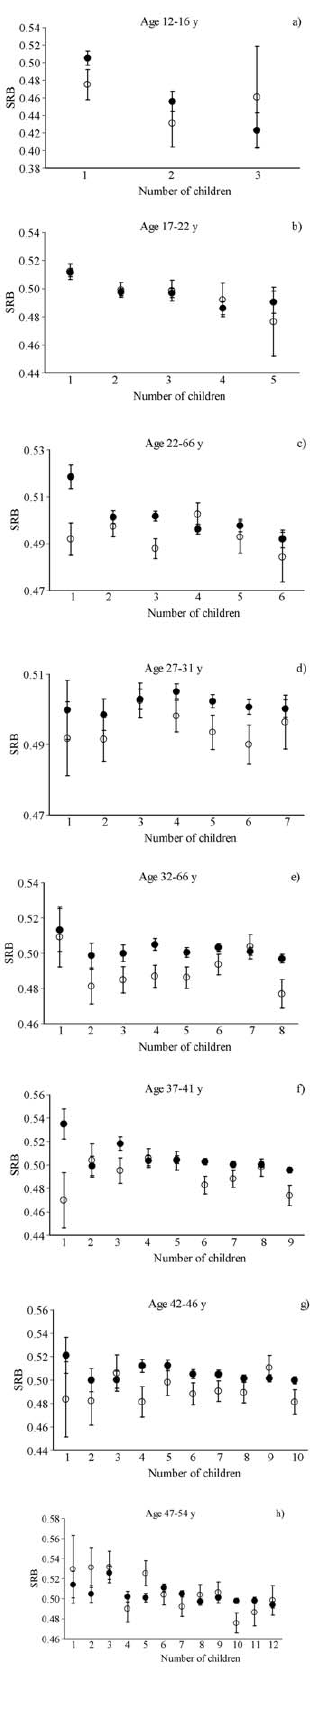
Figure 2. SRBs for each woman who gave birth to one, two … up to 9 children in relation to ownership of dwellings are presented. The age of these mothers is classified into eight groups (a– h). Values are mean 6 SE (black symbols owned, white symbols not owned).